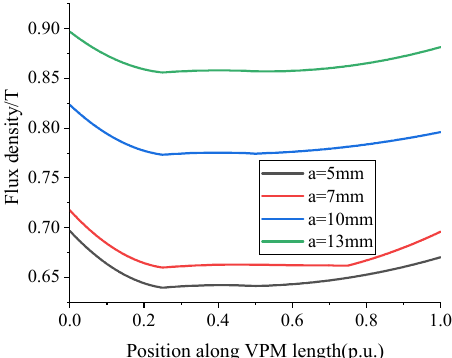
Figure 9. Low-coercive permanent magnetic flux density.